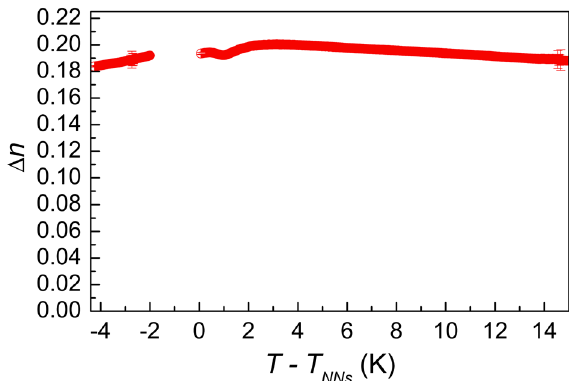
FIG. 5. Temperature dependence of anisotropy of index of refraction. In the temperature region where the orientation is not homogeneous, we were not able to measure Δ n